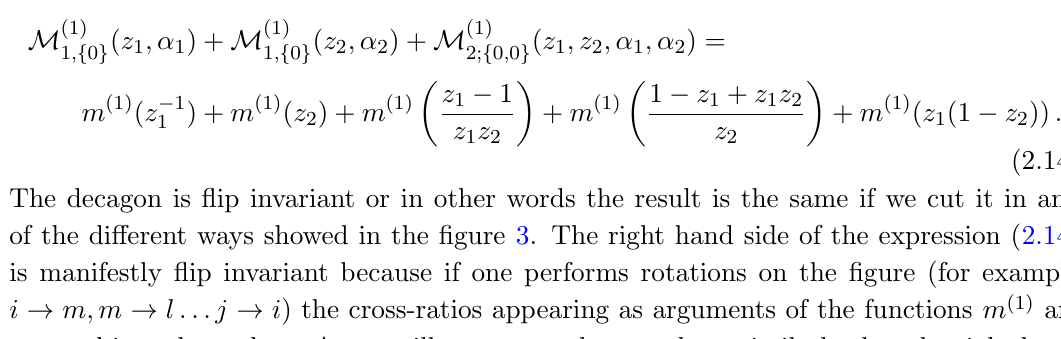
m; m l : : : j i , the result does not ! ! !